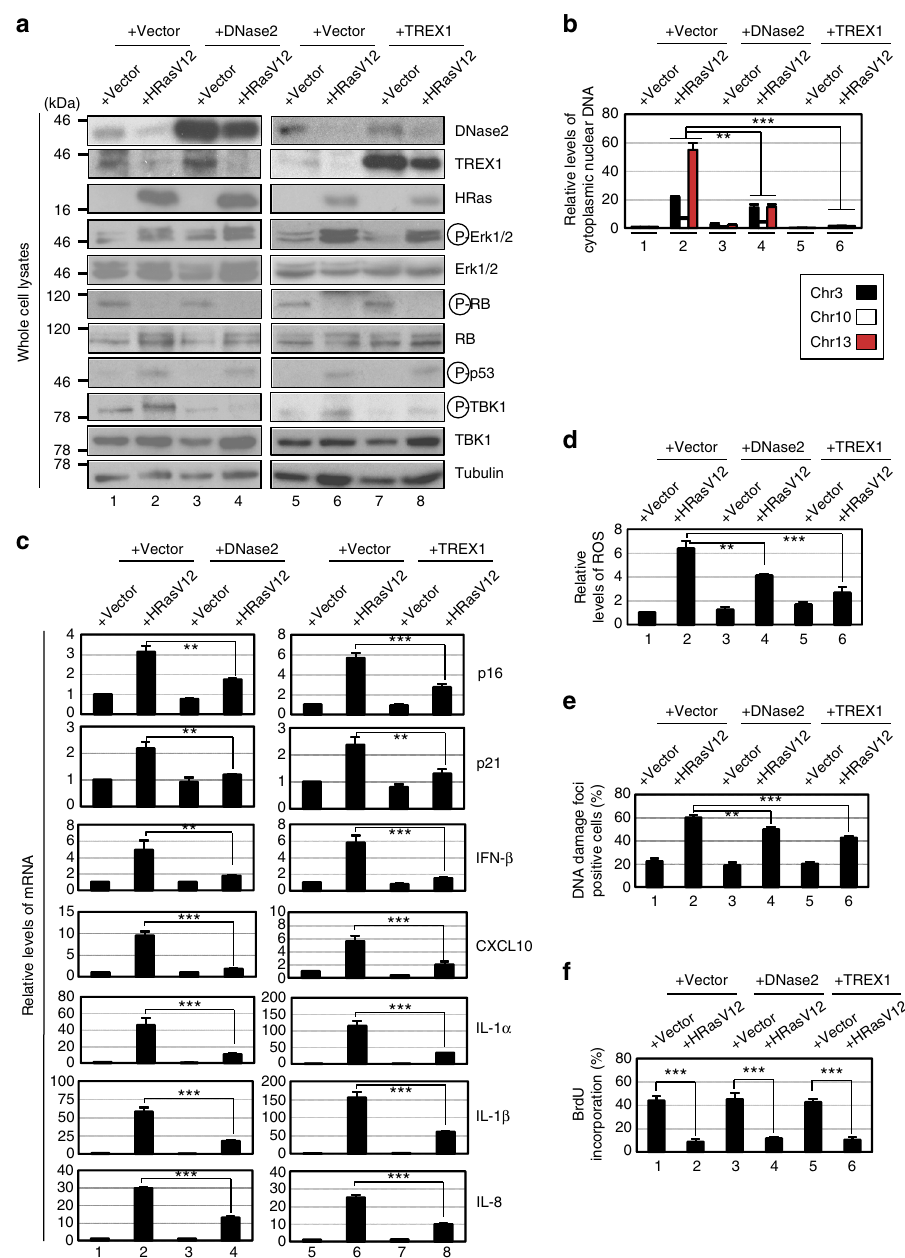
Fig. 3 Cytoplasmic DNases prevents cytoplasmic accumulation of nuclear DNA and SASP. a – f Pre-senescent TIG-3 cells were infected with retrovirus encoding fl ag-tagged DNase2 (lanes 3 and 4), TREX1 (lane 7 and 8) or empty vector (lanes 1, 2, 5, and 6). After selection with puromycin, cells were super- infected with retrovirus encoding HRasV12 and subjected to western blotting using antibodies shown right ( a ), qPCR analysis for cytoplasmic accumulation of nuclear DNA ( b ), RT-qPCR analysis of SASP factor gene expression ( c ), analysis of intracellular ROS levels ( d ), immuno fl uorescence staining for markers of DNA damage ( γ -H2AX and pST/Q substrate) ( e ) or BrdU incorporation analysis ( f ). Tubulin was used as a loading control ( a ). The histograms indicate the percentage of nuclei that contain more than 3 foci positive for both γ -H2AX and pST/Q staining ( e ). The representative data from three independent experiments are shown. For all graphs, error bars indicate mean ± standard deviation (s.d.) of triplicate measurements. (** P < 0.01. *** P < 0.001; one-way